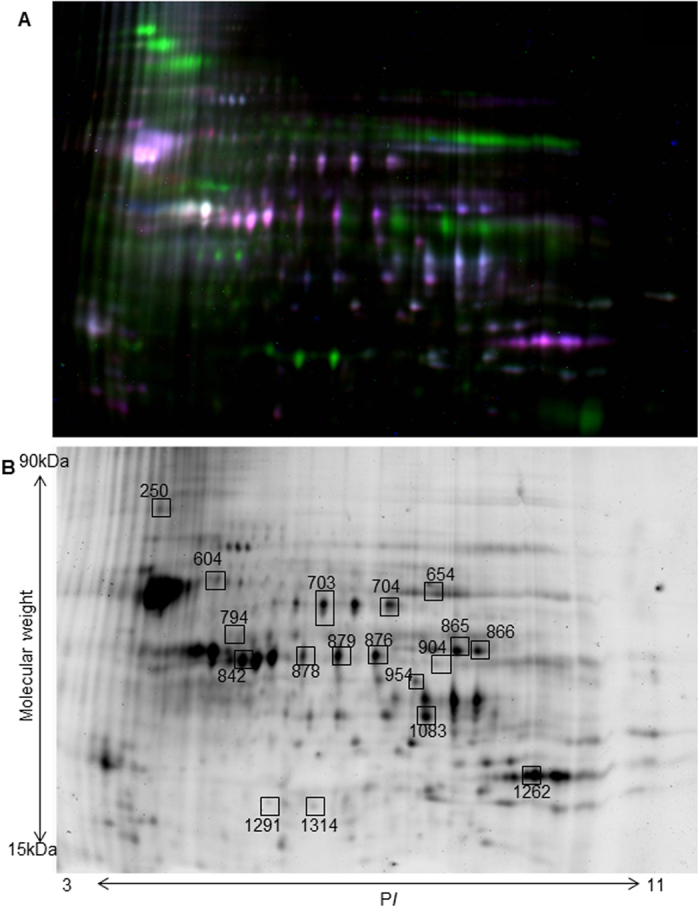
2D gel DIGE analysis of normal, degenerated and regenerating zebrafish retina.(A) Fluorescent gel image of protein spots from zebrafish retina. Normal zebrafish retina (Cy3/Red), degenerated retina (Cy5/Blue) and regenerating zebrafish retina (Cy2/green) are represented in the gel. (B) Representative image of protein spots from normal zebrafish retina. Numbered spots indicate those which were identified to be differentially expressed.